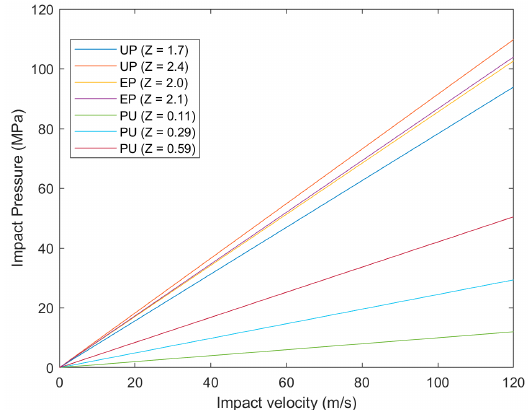
Figure 3. Using Equation (1) and data obtained from Slot et al. [47], the impact velocity for droplets is plotted against the impact pressure for LEP coating materials (UP, unsaturated polyester; EP, epoxy and PU, polyurethane). Different plots of each polymer represent slight variations in composition, which lead to different acoustic impedances (given by Equation